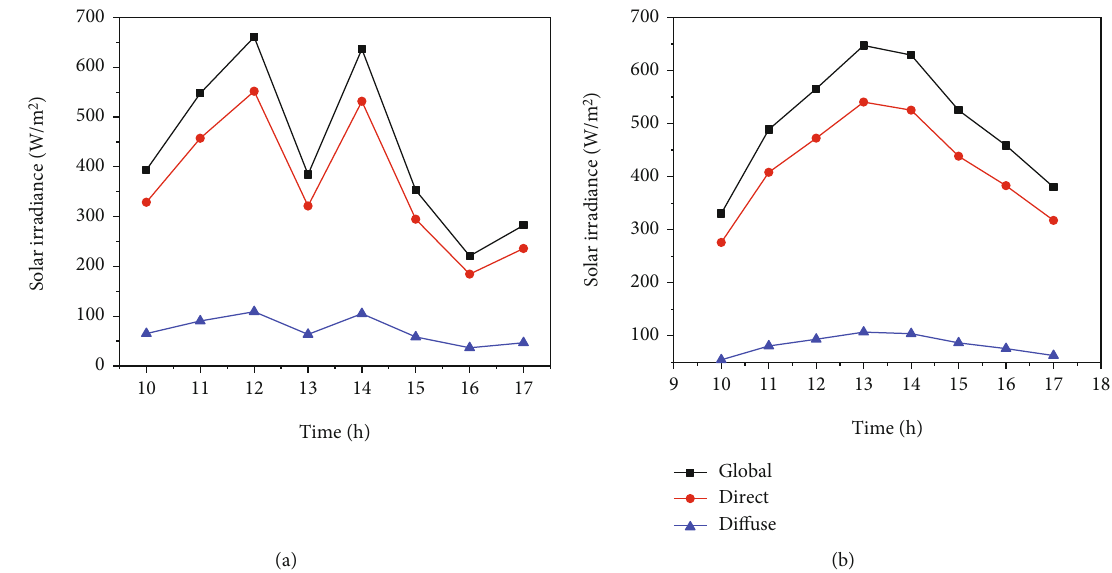
Figure 3: Variation of solar insolation with time of (a) day-1 and (b)